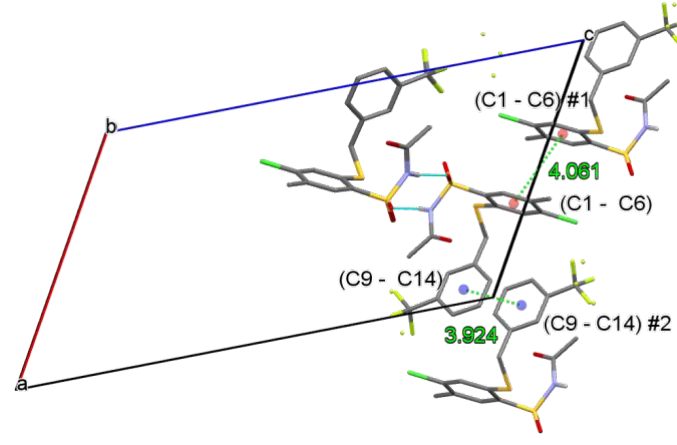
Figure 5. Ring stacking interactions, operating among the hydrogen-bonded chains. Symmetry